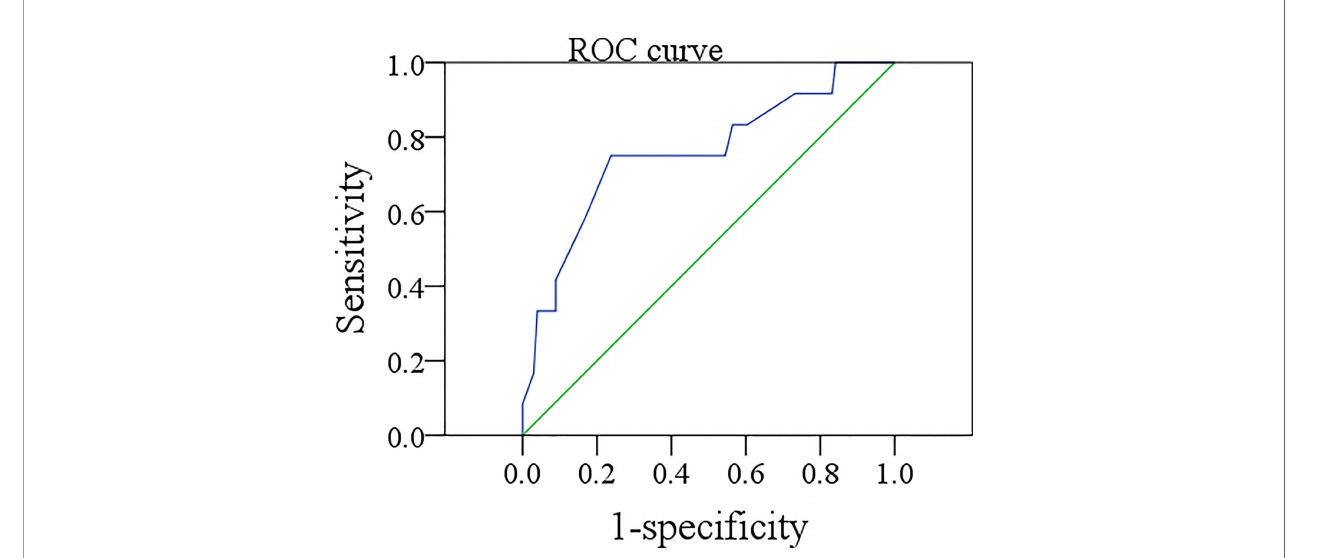
FIGURE 2 | ROC curve of the sonographic depth of invasion in predicting occult metastasis.